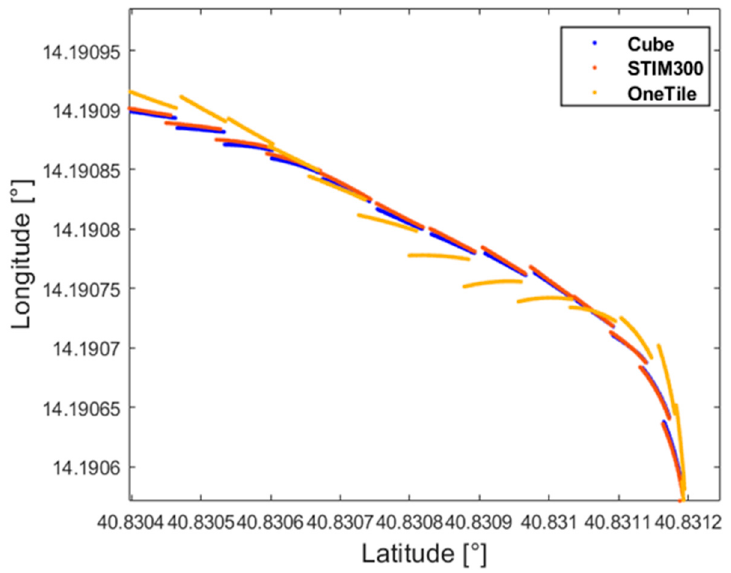
Figure 14. Position comparison.